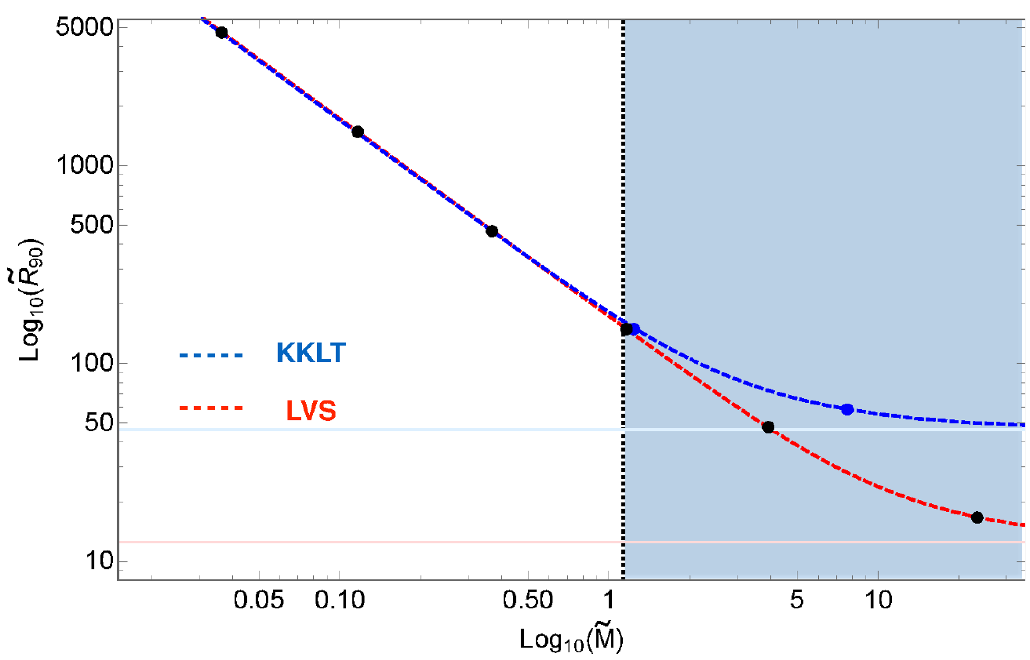
Figure 3 . We plot radius of the stars ~ R 90 (in LVS and KKLT) as a function of the star mass ~ M . Black dots correspond to the numerical solutions listed in table 1 obtained varying the core amplitude (cid:14) ~ ’ core from 10 (cid:0) 6 (extreme left black dot) to 10 (cid:0) 1 (extreme right black dot). The blue dots are the numerical solutions for the KKLT potential (for core amplitudes in the range 10 (cid:0) 6 to 10 (cid:0) 2 ) that coincide with the LVS results in the dilute regime (cid:14)(cid:31) core . 10 (cid:0) 3 , as expected. The red and blue dashed lines are found matching the numerical data with the function de(cid:12)ned in eq. (3.29). The light red and blue solid lines correspond to the asymptotic values obtained from eq. (3.30). The blue region corresponds to a background amplitude (cid:14) ~ ’ core & 10 (cid:0) 3 (or (cid:14) ~ (cid:31) core & 10 (cid:0) 3 ), where the approximations used are not fully reliable, as explained in the main